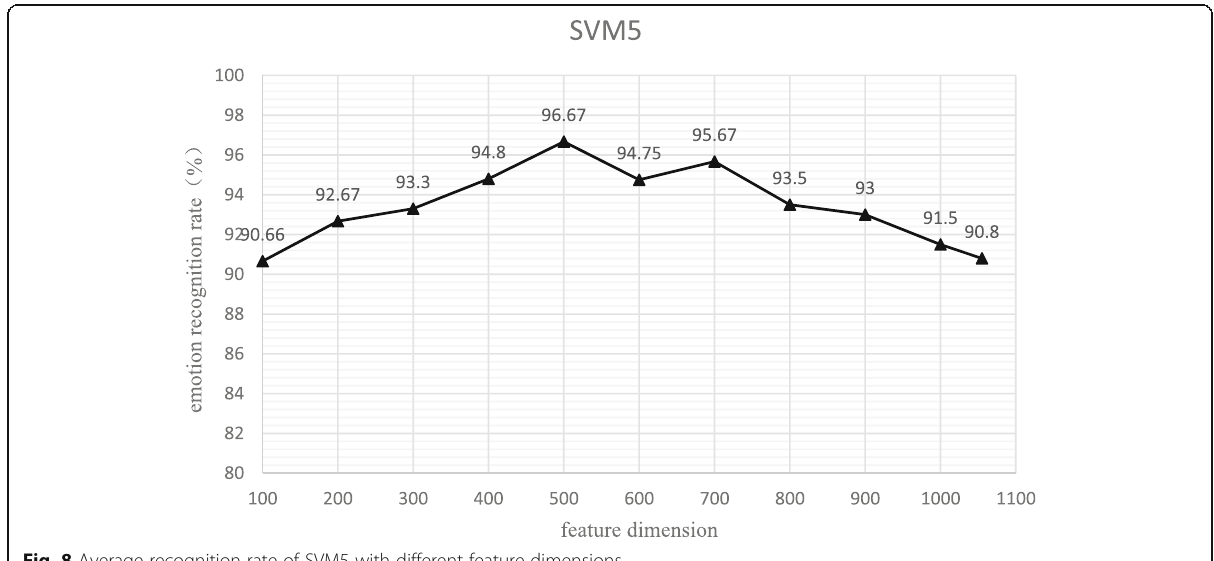
Fig. 8 Average recognition rate of SVM5 with different feature